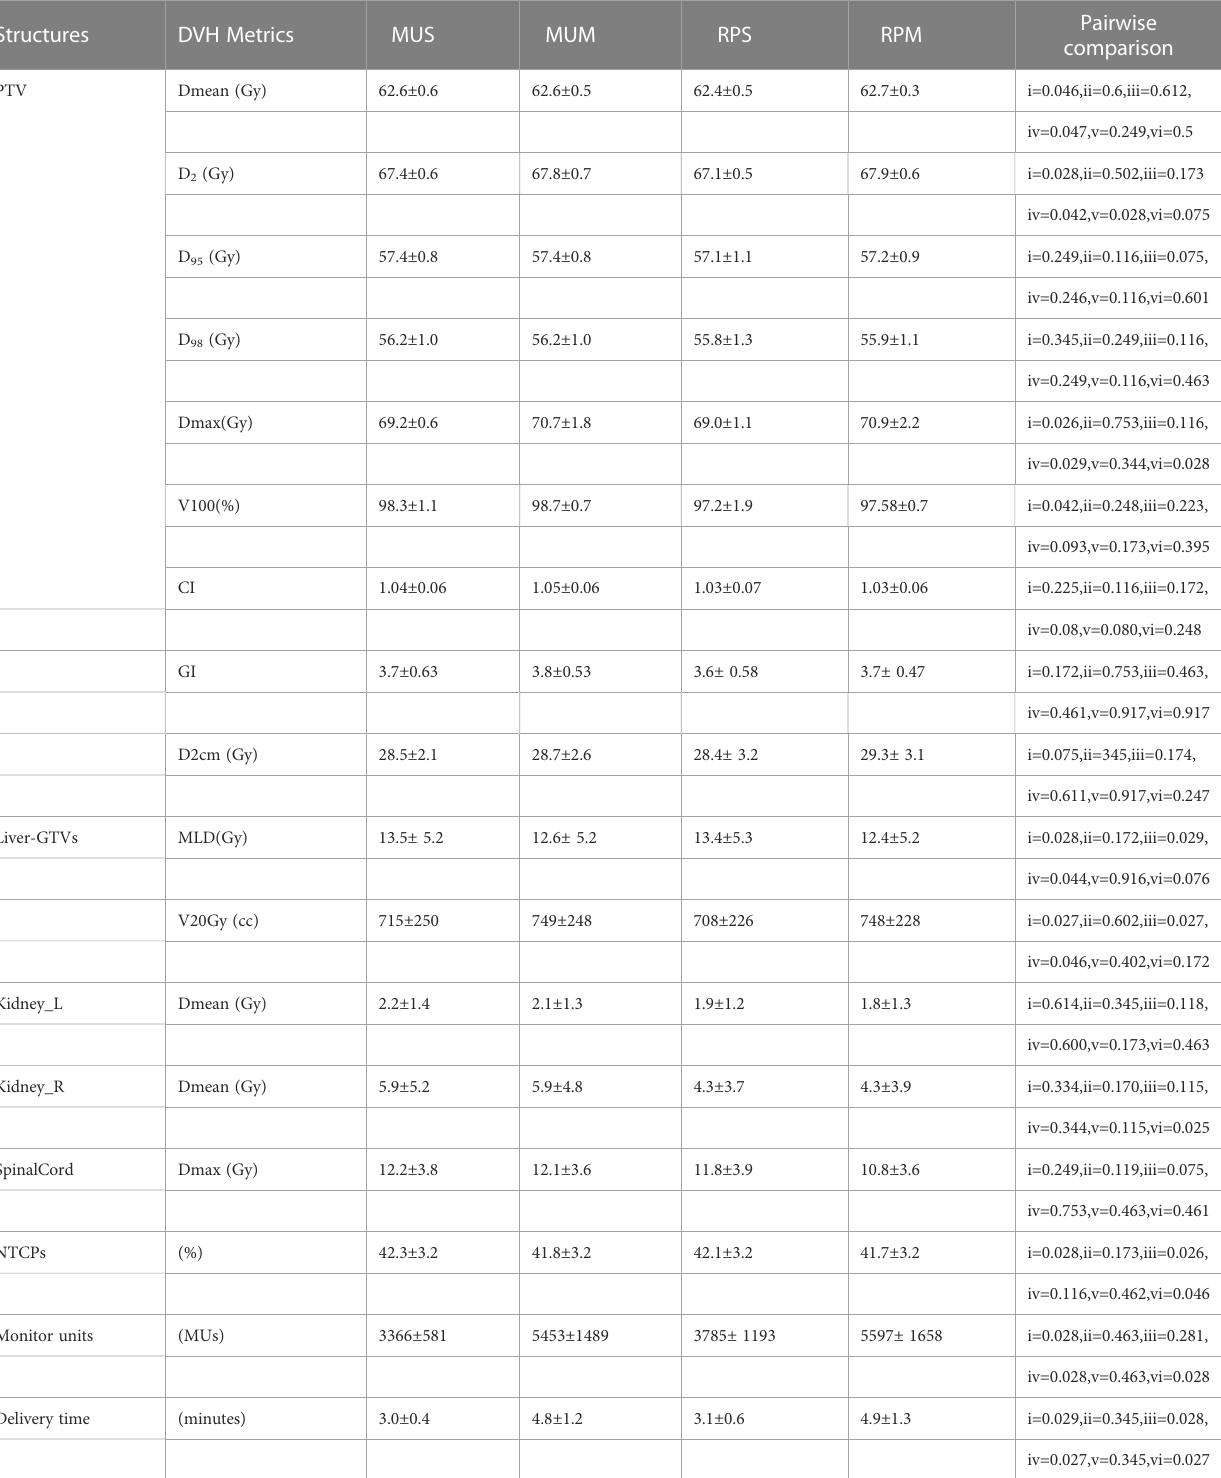
TABLE 3 Quantitative evaluation on the average, standard deviation, and range of DVH metrics for the PTV and OARs among MUS, MUM, RPS, and RPM.